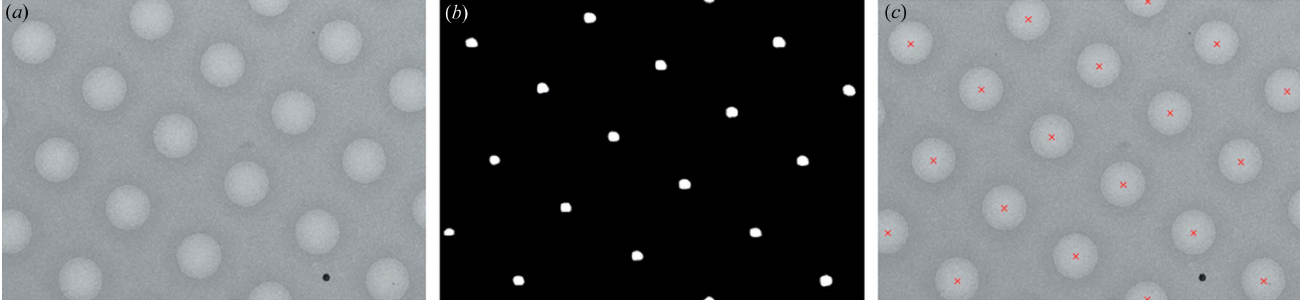
Figure 6 Example hole-center detection without lattice fitting. For some cases, taking the centroids of the high-probability regions predicted by the U-Net is sufficient. ( a ) Input image. ( b ) U-Net output. ( c ) Centroids from high-probability regions in U-Net output